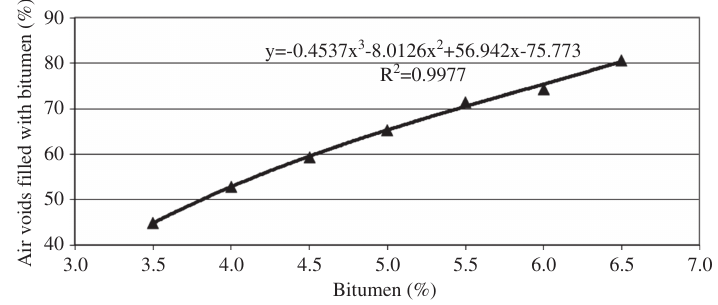
Figure 3 Relationship between air voids filled with bitumen and bitumen